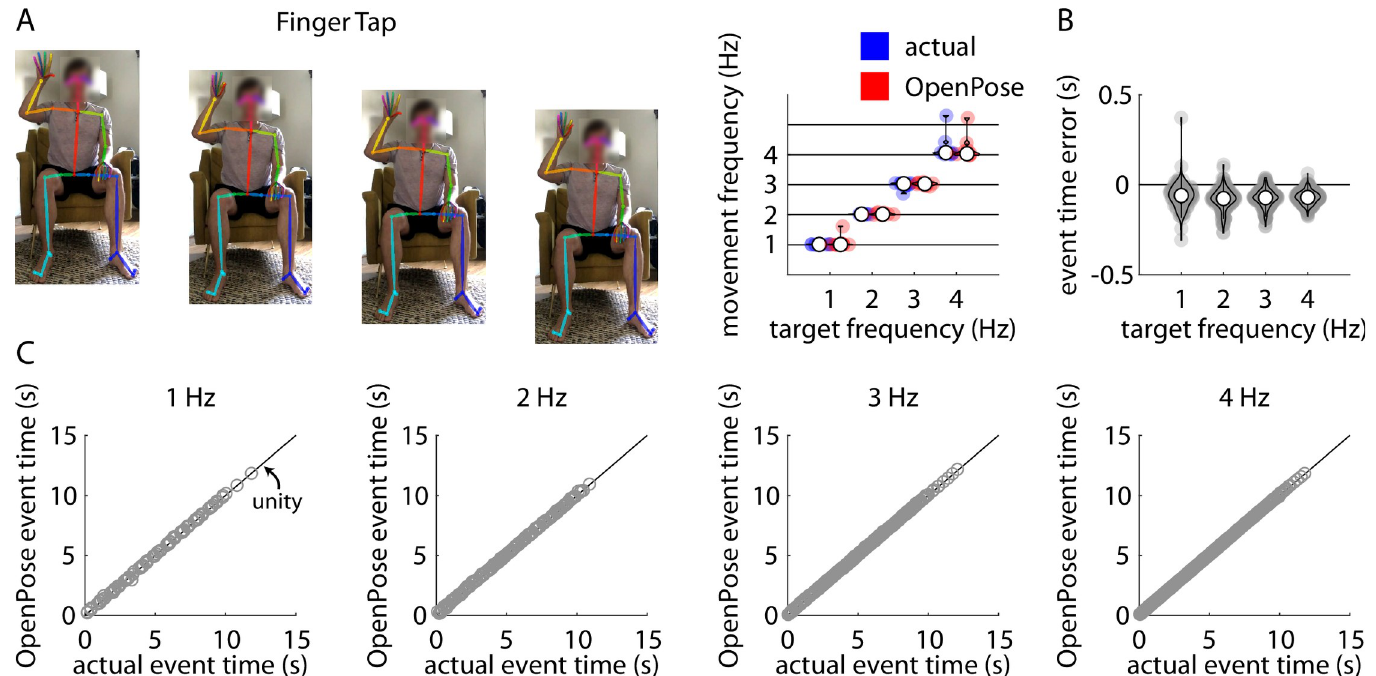
Fig 2. A) Representative example of stillframes from an OpenPose output video of a participant performing the finger tapping task (left) and violin plots showing comparisons of individual participant mean finger tapping frequencies measured manually (“actual”, blue) and using our pose estimation workflow (“OpenPose”, red) across all four target frequencies (right). B) Violin plots showing event time errors (i.e., differences between video timestamps of finger taps as measured manually and using pose estimation) for each individual finger tap across all participants. In Fig 2A and 2B, white circles indicate group mean values, shaded circles indicate individual data points. These conventions are consistent across Figs 2–6. C) Scatter plots showing relationships between the video timestamps of all individual finger taps across all participants as measured manually (x-axis) or using our pose estimation workflow (y-axis) across all four target frequencies. Relevant correlation coefficients are included in the Results section of the text for Figs 2–6.